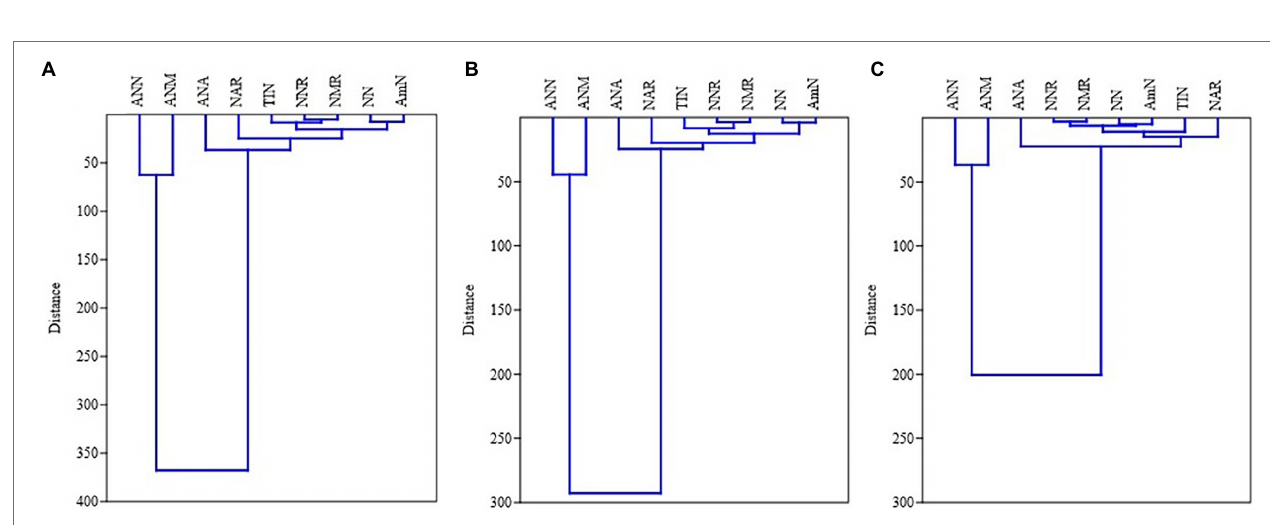
FIGURE 2 | Pearson correlation between the different nitrogen forms in (A) Masson pine pure forest (MPPF) and (B) Masson pine and camphor tree mixed forest (MCMF) stand across all litter treatments. Pearson correlation is significant at p < 0.05; all the non-significant values are shown with blank box. AmN: NH 4+ -N, NN: NO 3 − -N, TIN, total inorganic nitrogen; NAR, net ammonium rate; NNR, net nitrification rate; NMR, net mineralization rate; ANA, annual NH 4+ -N production; ANN, annual NO 3 − -N production; ANM, annual total inorganic nitrogen.